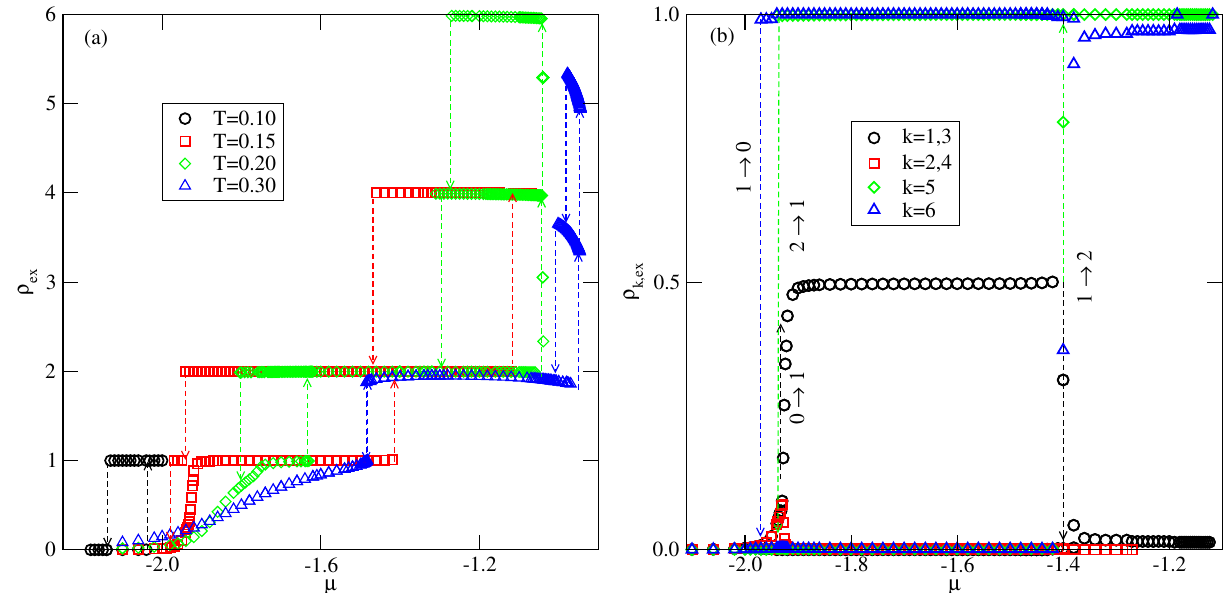
Figure 18. ( a ) The excess adsorption isotherms for the system with V o = − 1.2. ( b ) The excess densities of differently oriented particles ρ k , ex , recorded along the adsorption–desorption isotherm at T =